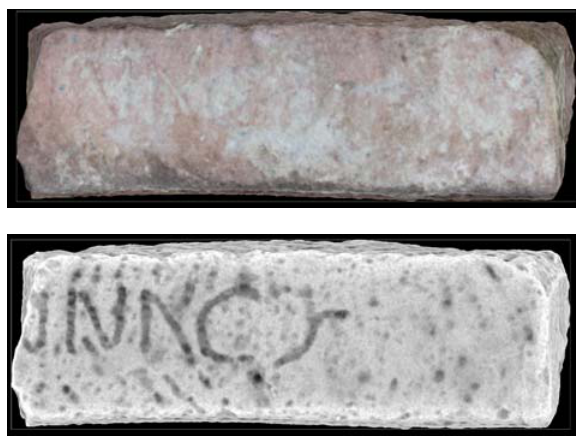
Figure 13: Opposite face of block n°6 (Face 3) and its PCV